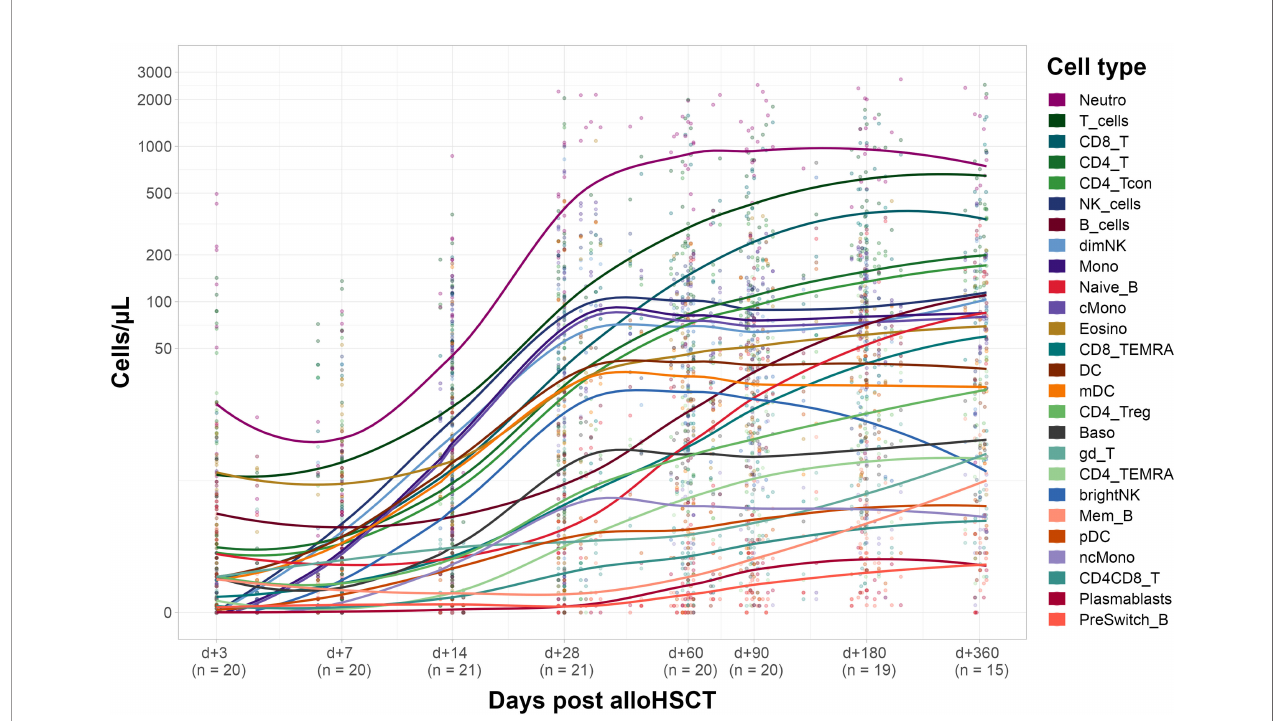
FIGURE 3 | Recipient immune cell reconstitution until day +360. Cell counts per µl whole blood post transplantation with fi tted polynomial surface; using local fi tting. T_cells, T cells; CD8_T, CD8 T cytotoxic cells; CD8_TEMRA, CD8 terminally differentiated memory T cells; CD4_T, CD4 T helper cells; CD4_Treg, Regulatory CD4 T cells; CD4_Tcon, Conventional CD4 T cells; CD4_TEMRA, CD4 terminally differentiated memory T cells; CD4CD8_T, CD4CD8 double positive T cells; gd_T, gamma- delta T cells; B_cells, B cells; Naive_B, Naive B cells; NonSwitch_B, Non-switched memory B cells; Mem_B, Memory B cells; Plasmablasts, Plasmablasts; NK_cells, NK cells; brightNK, CD56 bright NK cells; dimNK, CD56 dim NK cells; Mono, Monocytes; cMono, Classical monocytes; ncMono, Non-classical monocytes; DC, Dendritic cells; pDC, Plasmacytoid dendritic cells; mDC, Myeloid dendritic cells; Neutro, Neutrophils; Eosino, Eosinophils; Baso,